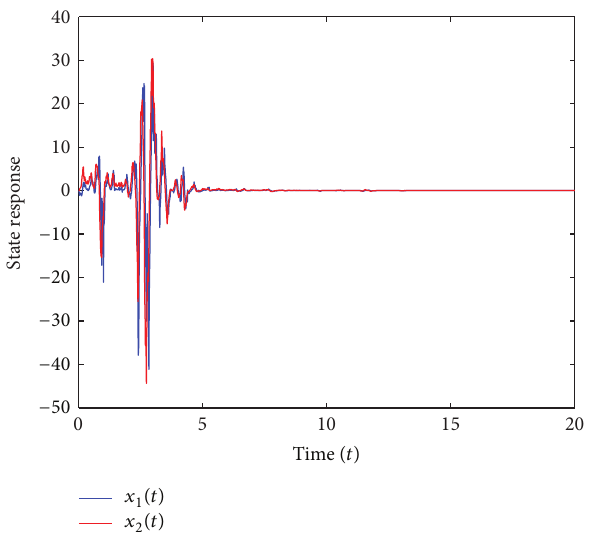
Figure 1: The simulation results of Example 1 when 𝜎 ̸=0 , 𝛿 < 0.1396 .